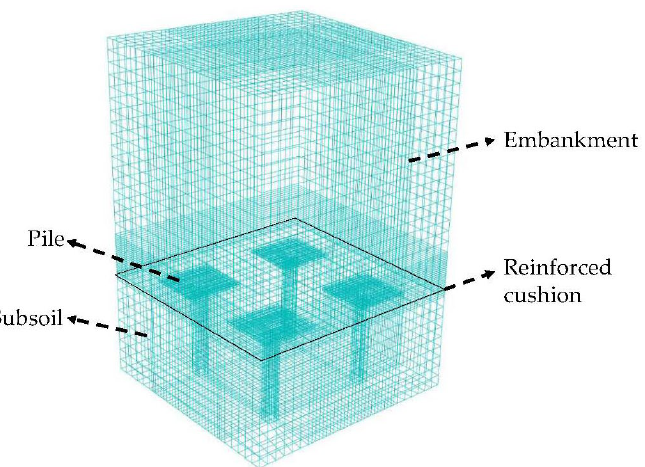
Figure 12. The soil-arching axis in the embankment, ( a ) the soil-arching crown between the horizontal Figure 10. Three-dimensional finite element model of the pile-supported reinforced embankment. adjacent piles; ( b ) the soil-arching crown between the diagonal adjacent Table 3. Test program.